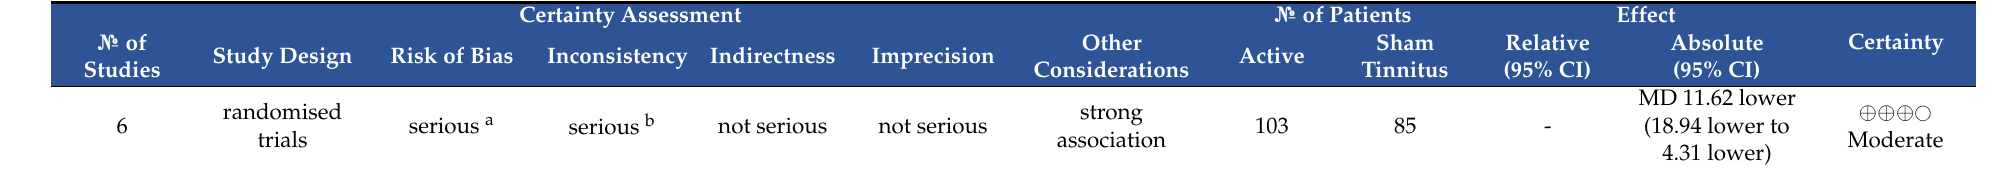
Table 5. GRADE assessment tinnitus.